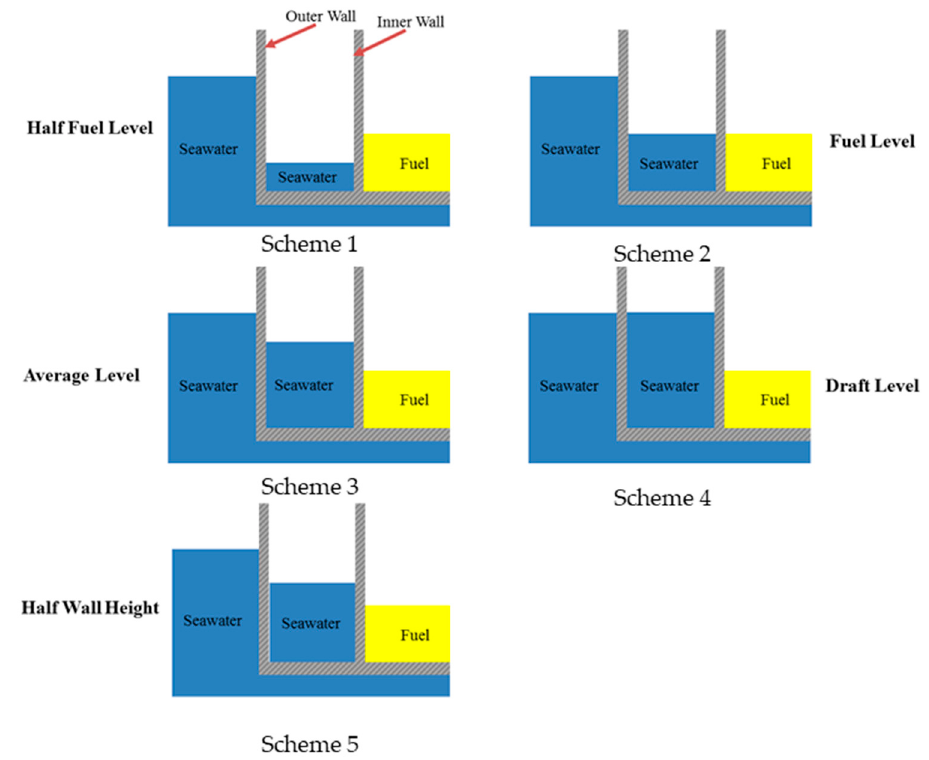
Figure 27. Sea water filling schemes.